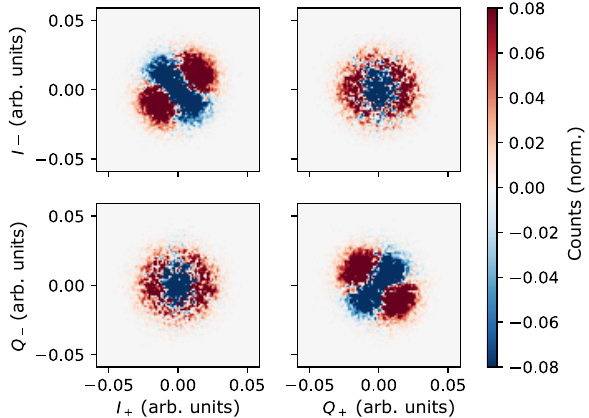
FIG. 12. Single pump two-mode quadrature histograms. Mea- sured for the mode pair adjacent to the pump mode ( (cid:4) = FSR). The pump-off data has been subtracted. The squeezing appears in the planes combining the I or Q quadratures of both modes. Plot- ting the I and Q quadratures of different modes shows amplified noise, resulting in donut-shaped subtracted histograms.